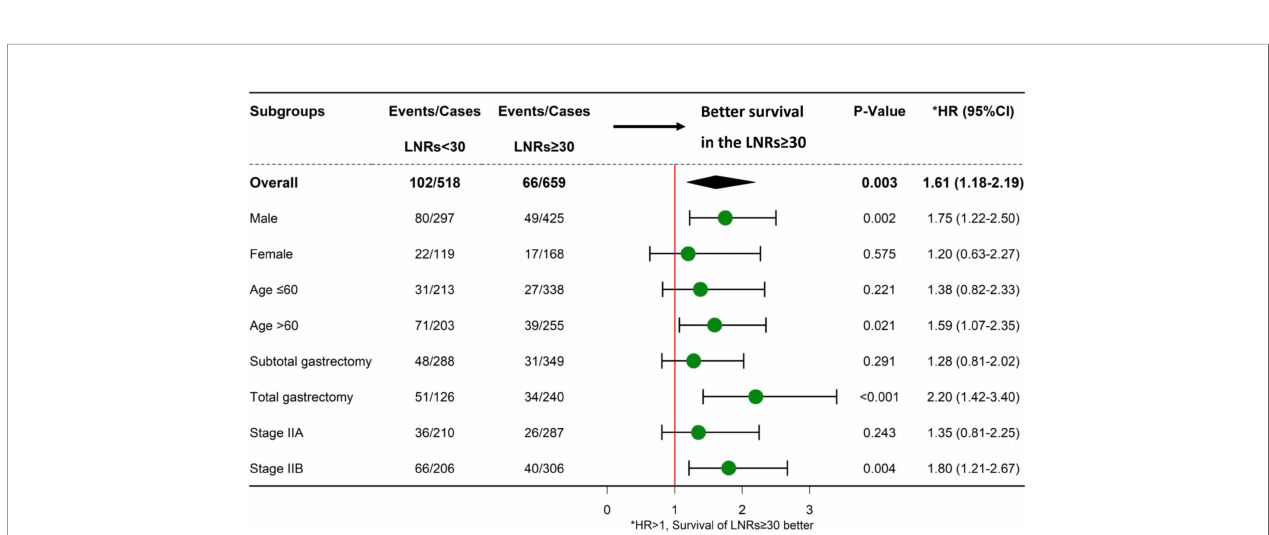
FIGURE 4 | Forest plot showing the impact of LNRs (<30 or LNRs ≥ 30) on survival in different subgroups.